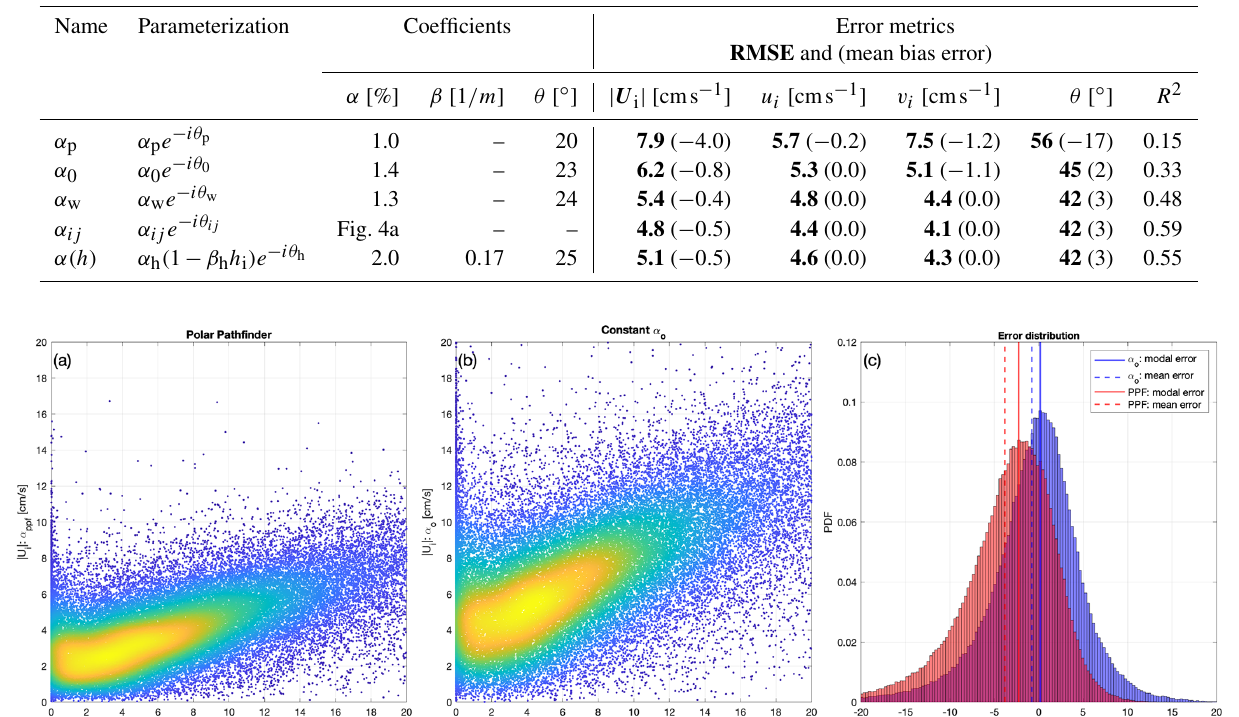
Figure 2. Scatter plot of free-drift sea ice speed estimates against buoy ice drift speed (a) for the NSIDC Polar Pathfinder free-drift input data and (b) for linear free drift with an optimized wind–ice–ocean transfer coefficient (no ocean currents). The color scale indicates the density of points on the scatter plot (kernel density estimate). The distribution of the error with respect to the buoy data is shown in panel (c) ; solid lines indicate the modal bin; dashed lines indicate the mean